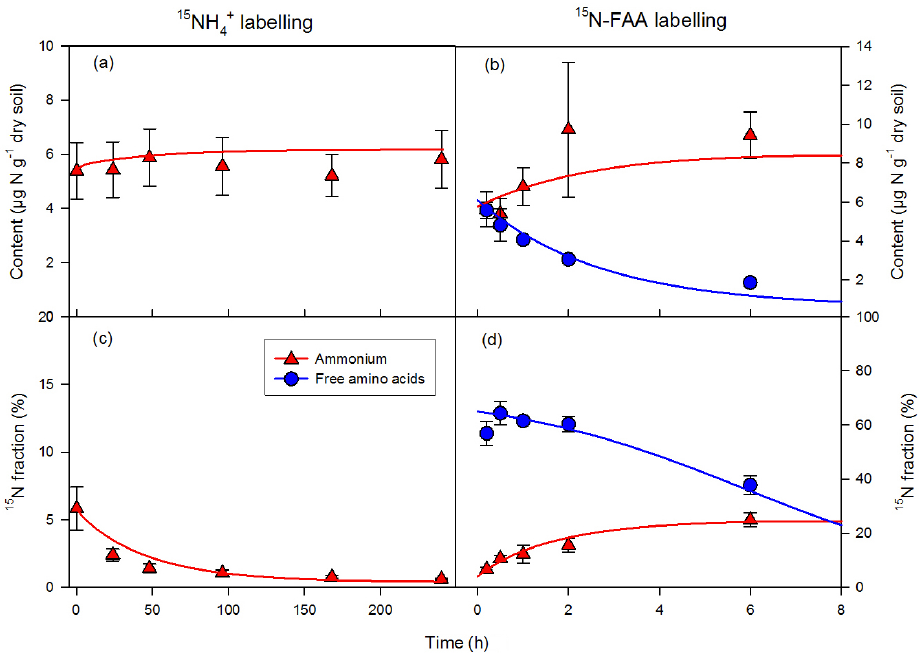
+ labelling and 15 N–FAA labelling; symbols indicate data obser- 4